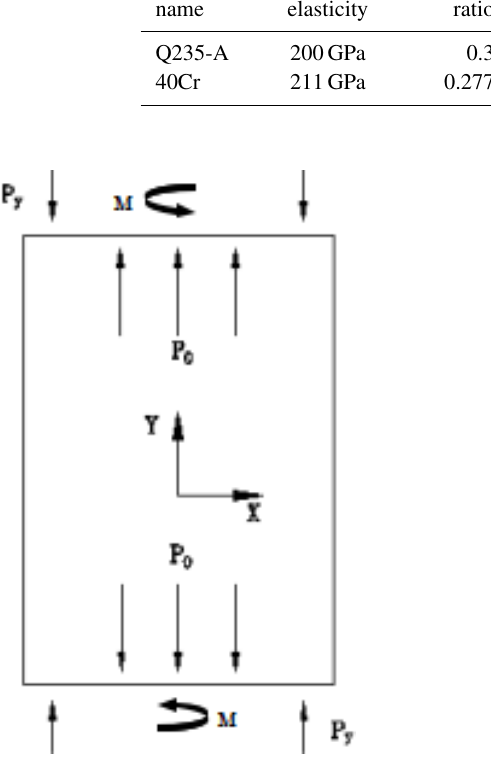
Figure 3. Mechanical model of frame.